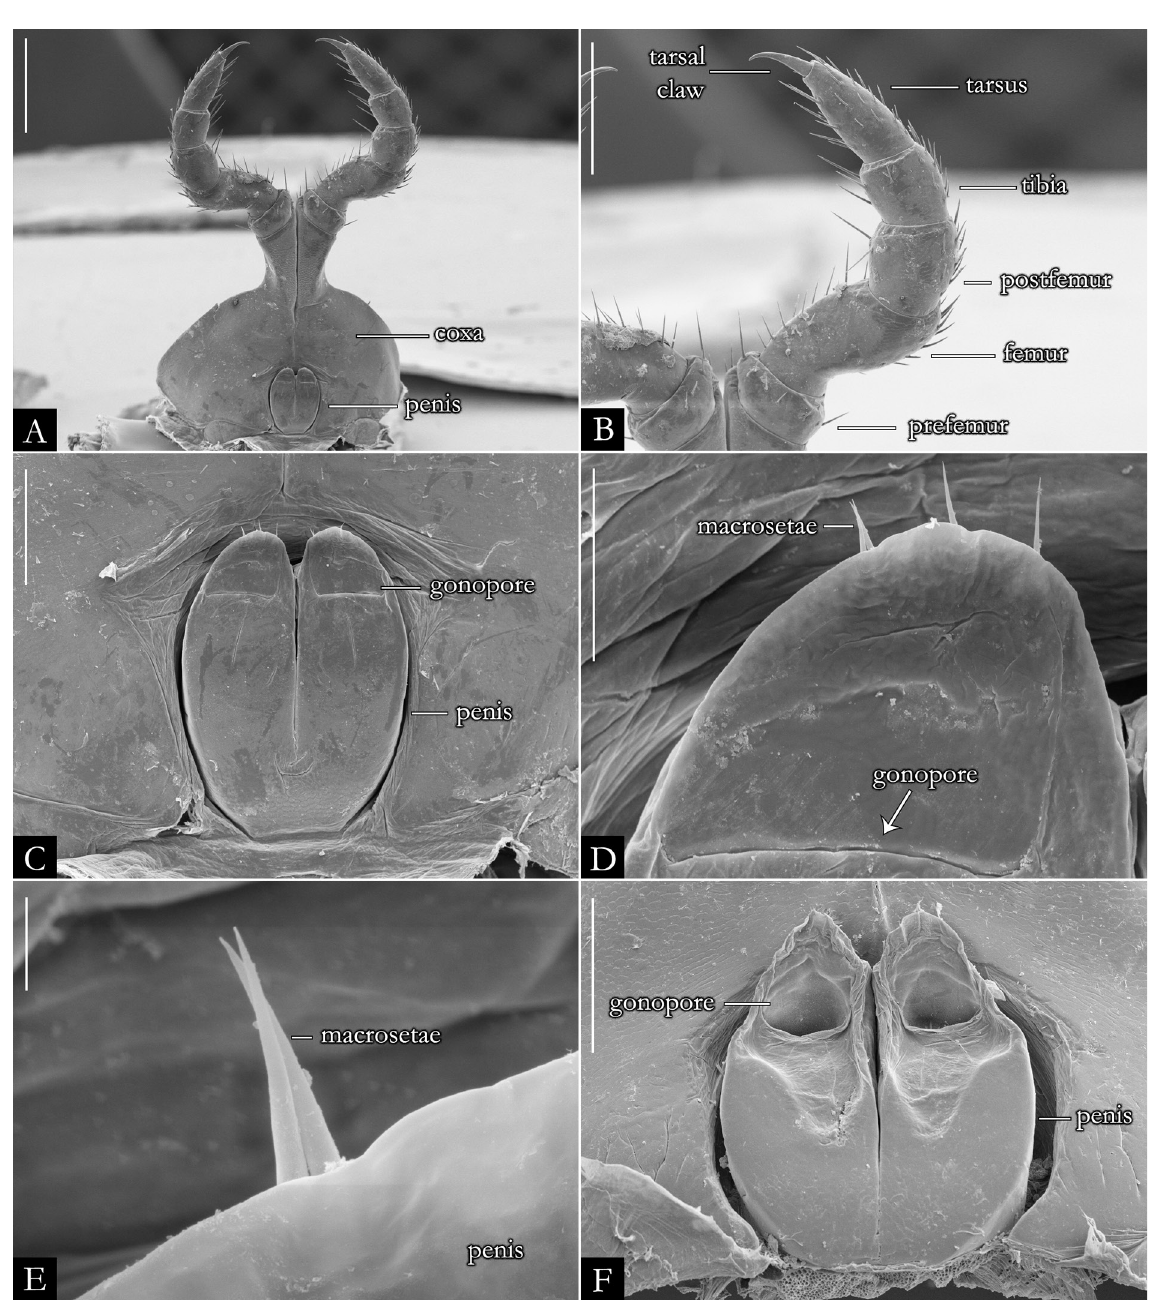
Fig. 31. SEM images of second leg-pair of males. A–E . Pseudonannolene halophila Schubart, 1949 (IBSP). F . P. sebastianus Brölemann, 1902 (IBSP). Scale bars: A–B = 0.5 mm; C, F = 0.2 mm; D = 0.05 mm; E = 0.005